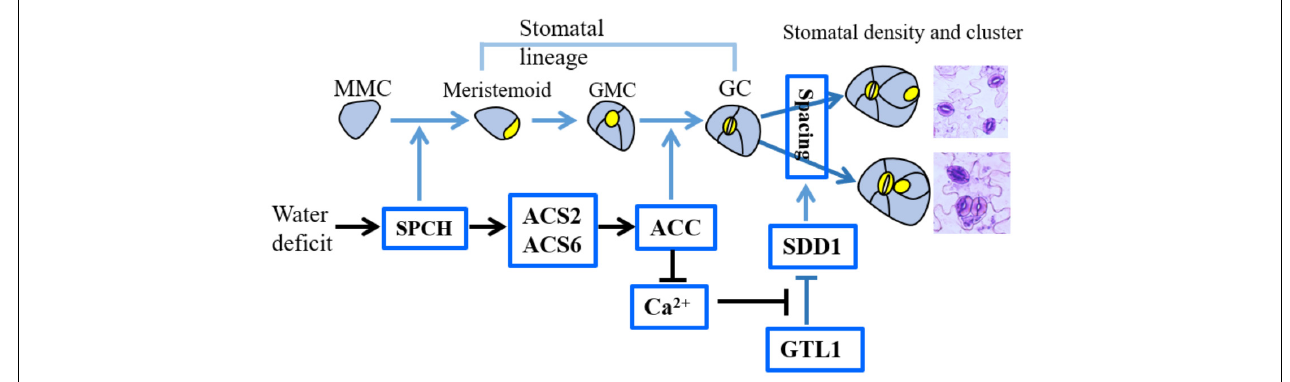
FIGURE 8 | Diagram illustrating the role of ACS2/6 expression and ACC accumulation in the integration of SPCH-initiated stomatal development with SDD1-dependent stomatal spacing. In the top row depicting stomatal development, non-stomatal lineage cells, such as leaf epidermal cells, protodermal cells, and meristemoid mother cells (MMCs), are shown in blue–gray, while stomatal lineage cells, including meristemoid cells, guard mother cells (GMCs), and guard cell (GCs), are indicated in bright yellow. The factors involved in this study are shown in the bright blue box. Under water deficit conditions, SPCH increases ACS2 and ACS6 expressions. Next, ACS2/6-generated ACC accumulation may be involved in two processes: (1) promoting the transformation of GMCs into GCs, and (2) inducing a shortage of Ca 2 + in stomatal lineage cells and decreasing SDD1 activity. As a consequence of these two processes, ACS2/6-generated ACC accumulation increases stomatal density, stomatal index and the rate of clustering. Relationships among these events are indicated by arrows: blue for conclusions drawn from the literature, and black for findings of the present study.